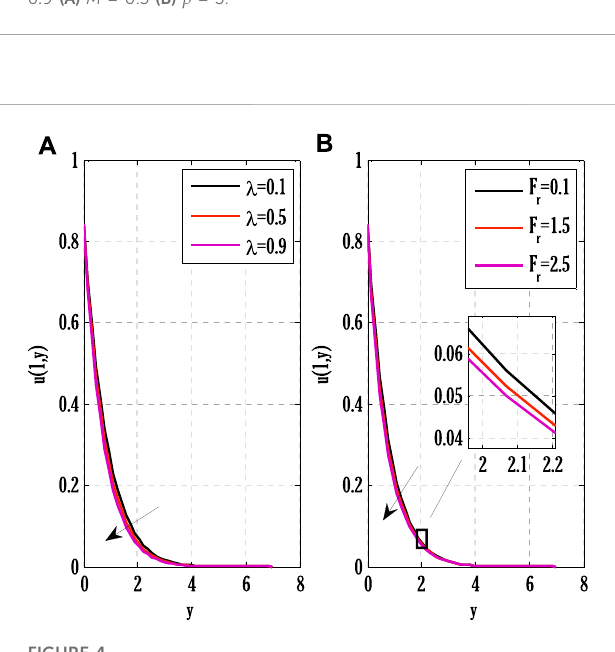
FIGURE 4 Effect of porosity parameter and inertia coef fi cient on velocity pro fi le using N t (cid:2) 150 , N y (cid:2) 45 , L (cid:2) 7 , t f (cid:2) 1 , E c (cid:2) 0 . 9 , N t (cid:2) 0 . 1 , N b (cid:2) 0 . 15 , P r (cid:2) 1 , S c (cid:2) 1 , R d (cid:2) 0 . 1 , M (cid:2) 0 . 9 , β (cid:2) 3 , λ 1 (cid:2) 0 . 1 , μ 1 (cid:2) 0 . 05 , λ 2